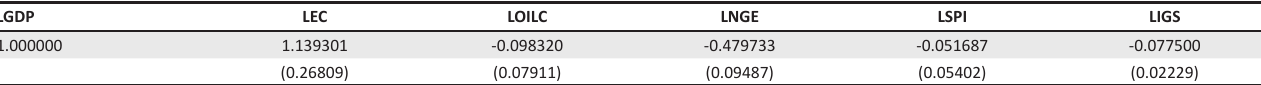
TABLE 5: Normalised cointegrating coefficients (standard error in parentheses). LGDP